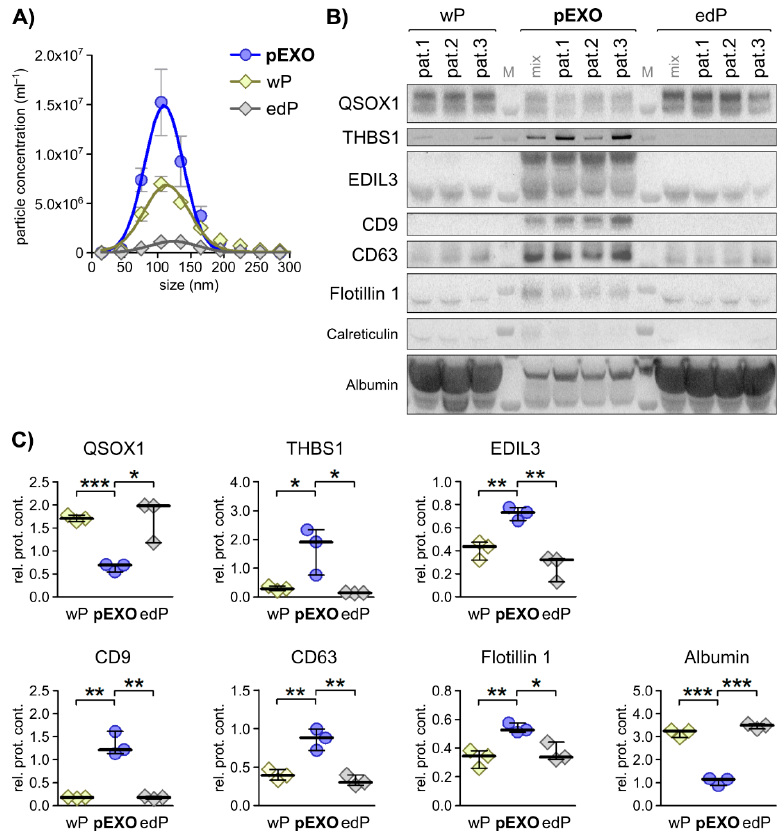
Figure 2. Selected primary fibroblast activation status dependent EXO markers display specificity to blood EXOs in matched CRC patient plasma. ( A ) Particle size distribution of patient-matched plasma EXOs (pEXO) in comparison to whole plasma (wP) and EXO-depleted plasma (edP) as measured by NTA. ( B ) Immunoblot analysis of quiescin sulfhydryl oxidase 1 (QSOX1), thrombospondin 1 (THBS1), EGF-like repeats and discoidin domains 3 (EDIL3), the EXO markers CD9, CD63 and Flotillin 1, including calreticulin as negative control, and albumin in wP, pEXO and edP protein lysates. ( C ) Graphical analysis of immunoblots shown in (B) using ImageJ, comparing signal strength to pEXO mix. Unpaired t -test: * p < 0.05, ** p < 0.01, *** p < 0.001. In summary, the pEXO protein content correlates to our findings of fibroblast-de- rived EXO levels of QSOX1, THBS1 and EDIL3, and IHC revealed significantly different expression of QSOX1 and EDIL3 in malignant compared to healthy colon tissue. This demonstrates the potential of the three markers to estimate tumour burden in blood sam- ples of CRC patients.